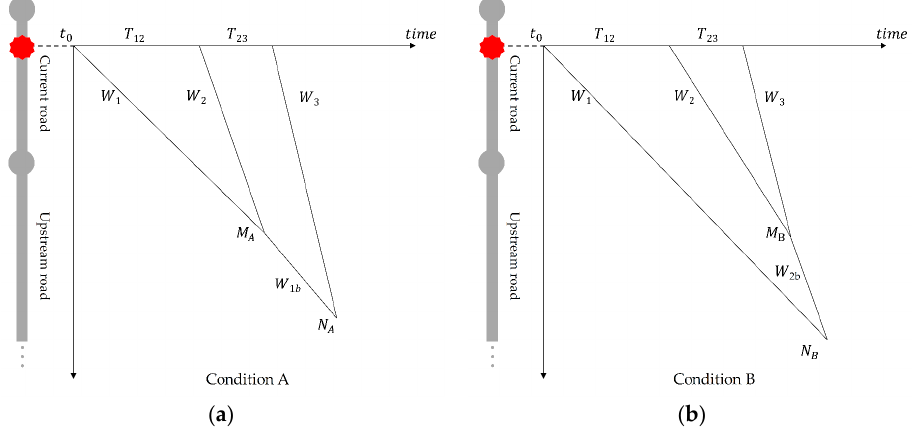
Figure 3. Basic conditions of shockwave superposition: ( a ) Condition A; and ( b ) Condition B.